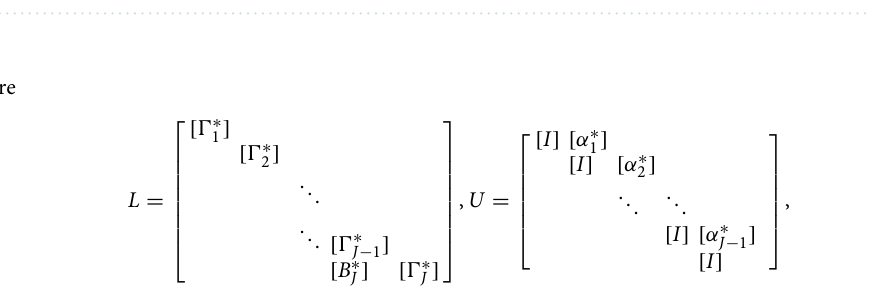
Table 2. The heat variations for nanofluids were compared to the information from references 65 and 66 .